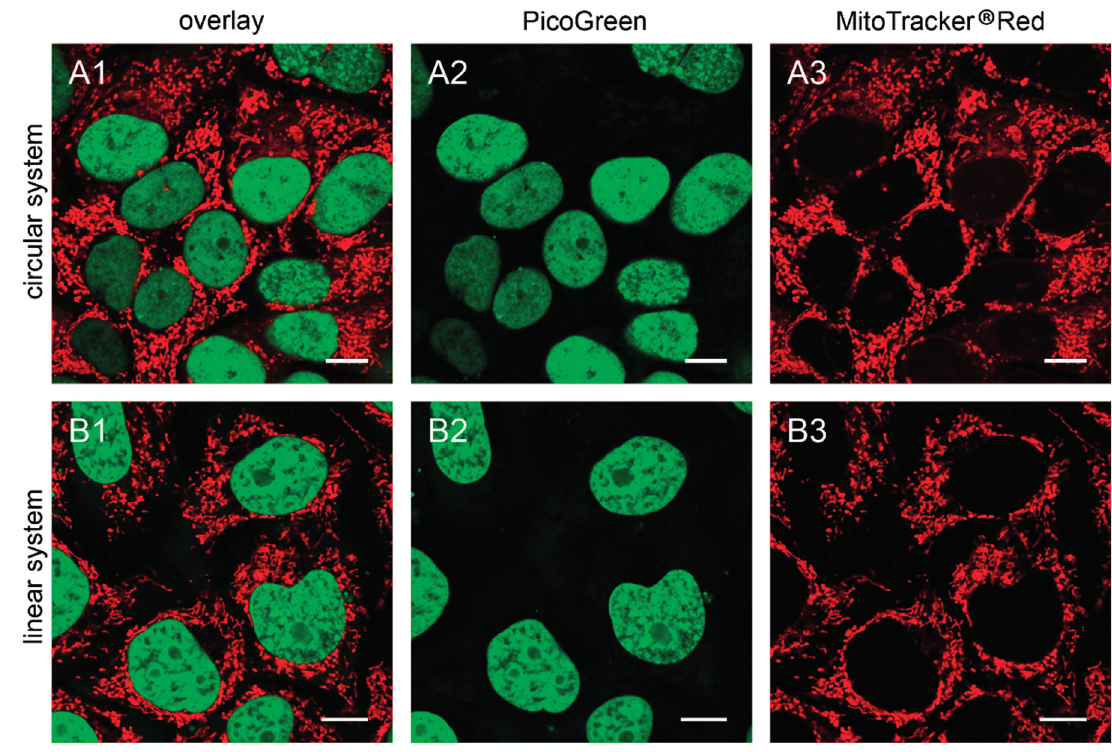
Figure 4. The 143B.TK − ρ 0 K7 cells transfected with depletion systems. The 143B.TK − ρ 0 K7 cells were transfected with pMEE-con ( A ) and MEE-con-module ( B ) and analyzed 24 h post-transfection by confocal laser scanning microscopy. Cells were incubated with PicoGreen ® (green color, panel A2 , B2 ) to stain DNA. The mitochondrial network was stained with MitoTracker ® Red CMXRos (red color, panel A3 , B3 ). Overlay of both fluorescent stainings are depicted in panel A1 and B1 . Calibration marks correspond to 10